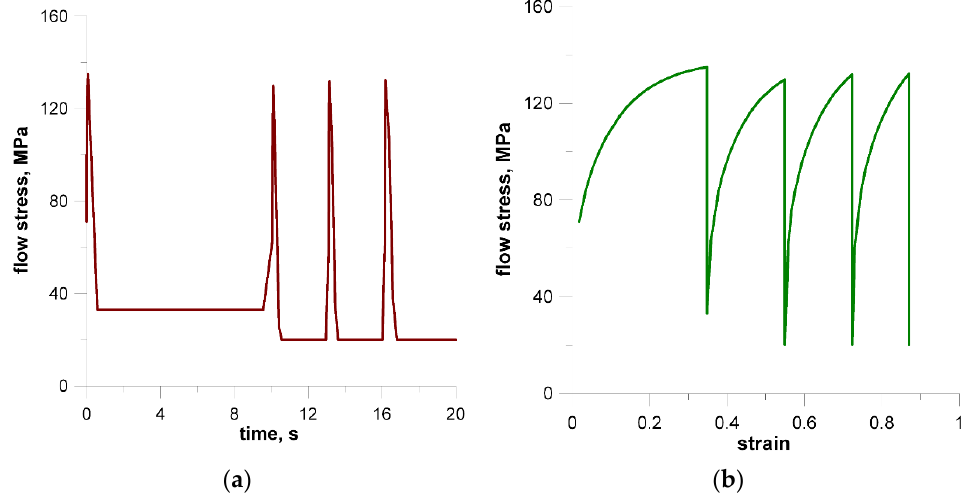
Materials 2021 , 14 , x FOR PEER REVIEW Figure 21. Flow stress changes in relation to time ( a ) and strain ( b ). Figure 21. Flow stress changes in relation to time ( a ) and strain ( b ). Figure 21. Flow stress changes in relation to time ( a ) and strain ( b ).